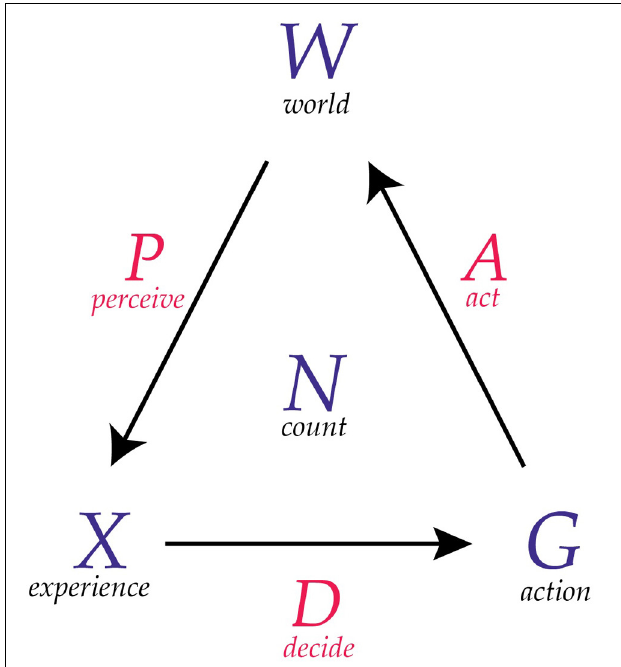
FIGURE 1 | A diagram of a conscious agent. A conscious agent has six components as illustrated here. The maps P , D , and A can be thought of as communication channels.